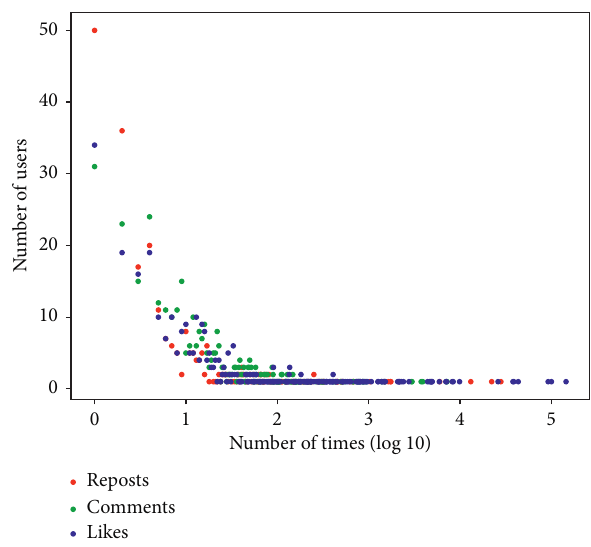
Figure 8: Distribution of reposts, comments, and likes of rumors about